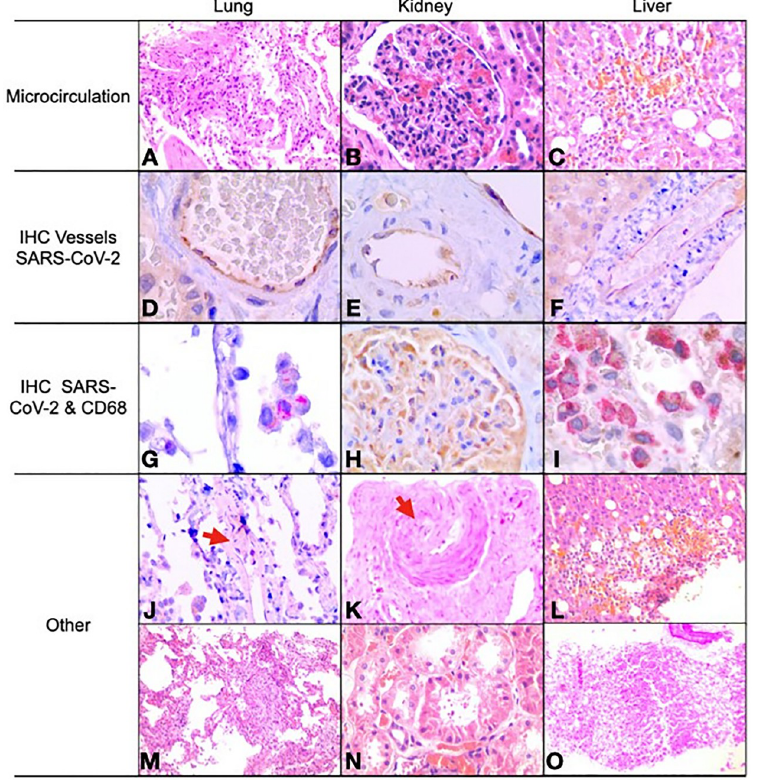
Fig 1. Histological and immunohistochemical findings. Microcirculation damage (A, B, C): A . Diffuse alveolar damage in exudative phase (H-E, 40X) B . Glomerulitis (H-E, 40X); C . Lobular hepatitis (H-E, 20X); Sars-Cov-2 in endothelial cells by immunohistochemistry (D, E, F): D . Anti-Sars-Cov2 cytoplasmic positivity in endothelial cells of pulmonary arterial vessels, 100X E . In endothelial cells of kidney arterial vessel, 100X and F . In endothelial cells of the hepatic arterial vessel, 40X. Sars-Cov-2 present in other cells (IHC) (G, H, I): G . Cytoplasmic positivity in intra alveolar macrophages with colocalization of anti-Sars-Cov2 and CD68, 100X; H . Visceral epithelial cells (podocytes) and glomerular parietal cells for anti-Sars-Cov2, 100X. I . Colocalization with anti-Sars-Cov2 (tobacco brown) and CD68 (red) in Kupffer cells, 100X; Other findings (J, K, L, M, N, O): J . Intraluminal organized thrombus in pulmonary arteriole, 40X K . Acute focal thrombotic microangiopathy in renal tissue (H-E, 10X); L . Hepatocellular hemorrhagic necrosis (H-E, 20X); M . Diffuse alveolar damage in proliferative phase (H-E, 40X); N . Cytoplasmic isometric vacuolization of renal tubular epithelium (H-E, 60X); O . Macrovesicular hepatic steatosis (H-E, 4X).